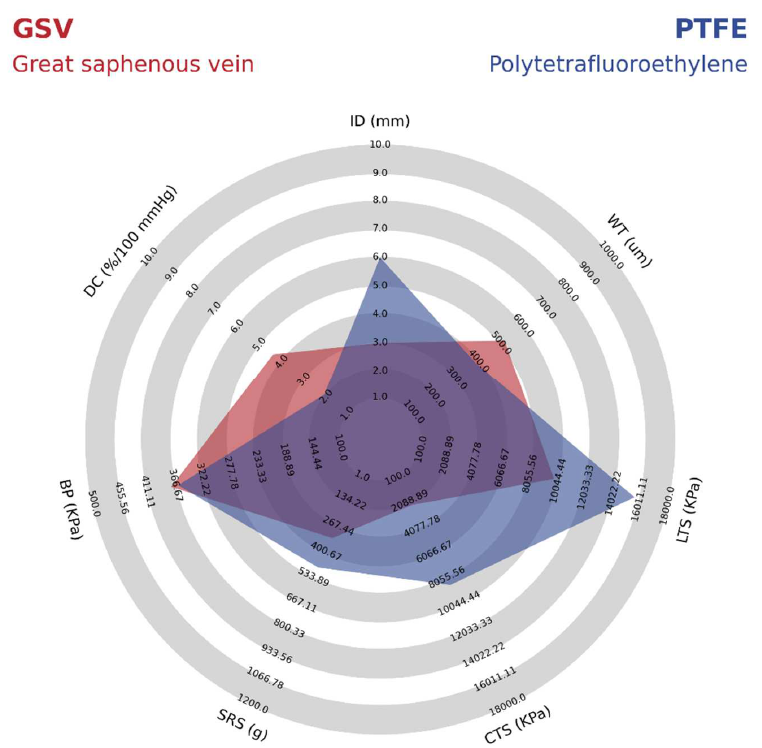
Figure 4. Mechanical properties comparison of the great saphenous vein, as a gold standard, and PTFE. Mechanical properties identified include Internal diameter (ID), wall thickness (WT), longitudinal tensile strength (LTS), circumferential tensile strength (CTS), suture retention strength (SRS), burst pressure (BP), and dynamic compliance (DC). Chart generated from the Python library developed by StatsBomb/Anmol Durgapal (accessed on 29 May 2022) [29].